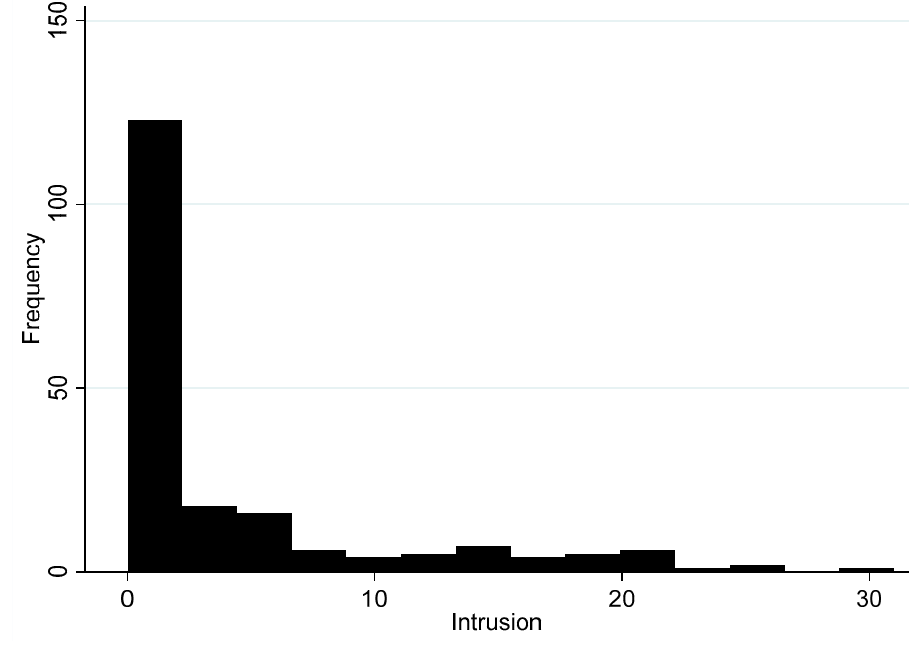
Figure 4. Histogram of intrusion subscale ( n = 198).